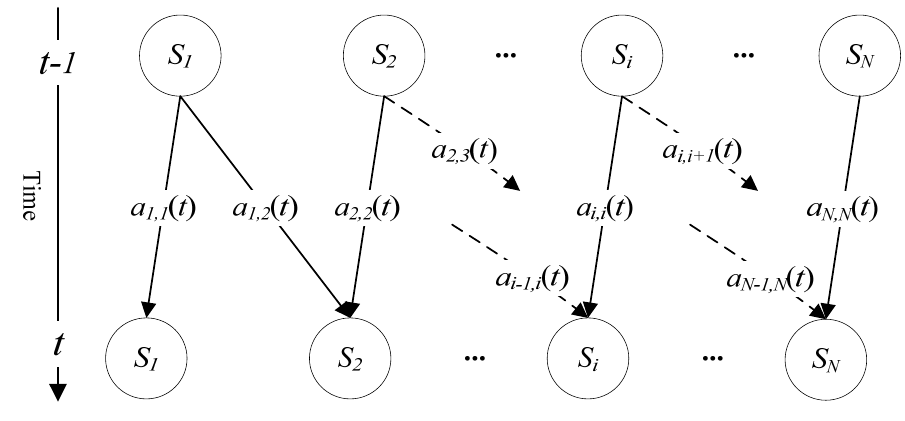
Figure 5. Illustration of corn progress stage transition along a life